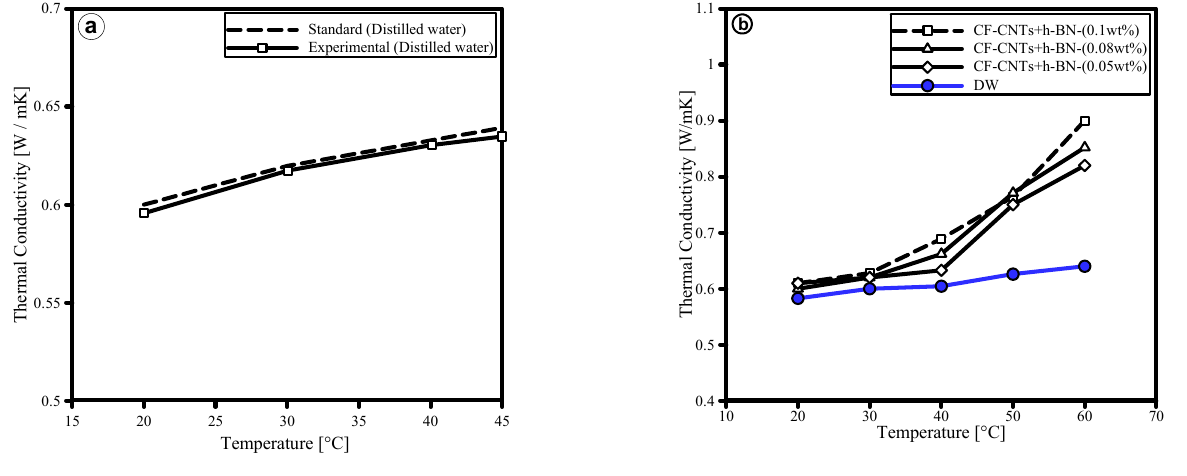
Figure 7. Thermal conductivity of ( a ) distilled water (experimental data, National Institute of Tech- nology [33]) and ( b ) water-based hBN/CF-CNTs hybrid nanofluid for different particle concentra- tions .